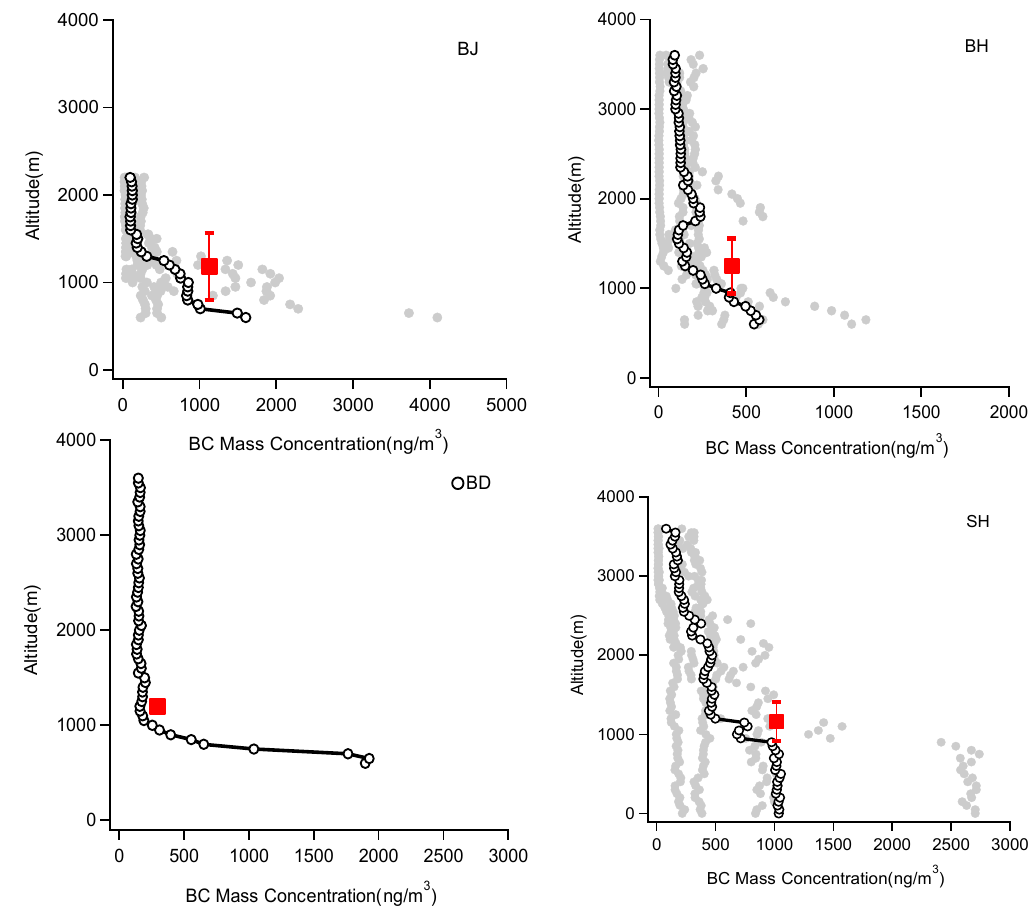
Figure 4. The measured vertical distributions of the rBC mass concentrations in the four areas (BJ, SH, BD, and BH) for all the flights. The grey dots show the results from all of the flights, and the open circles and line show the average results. The red square shows the height of the